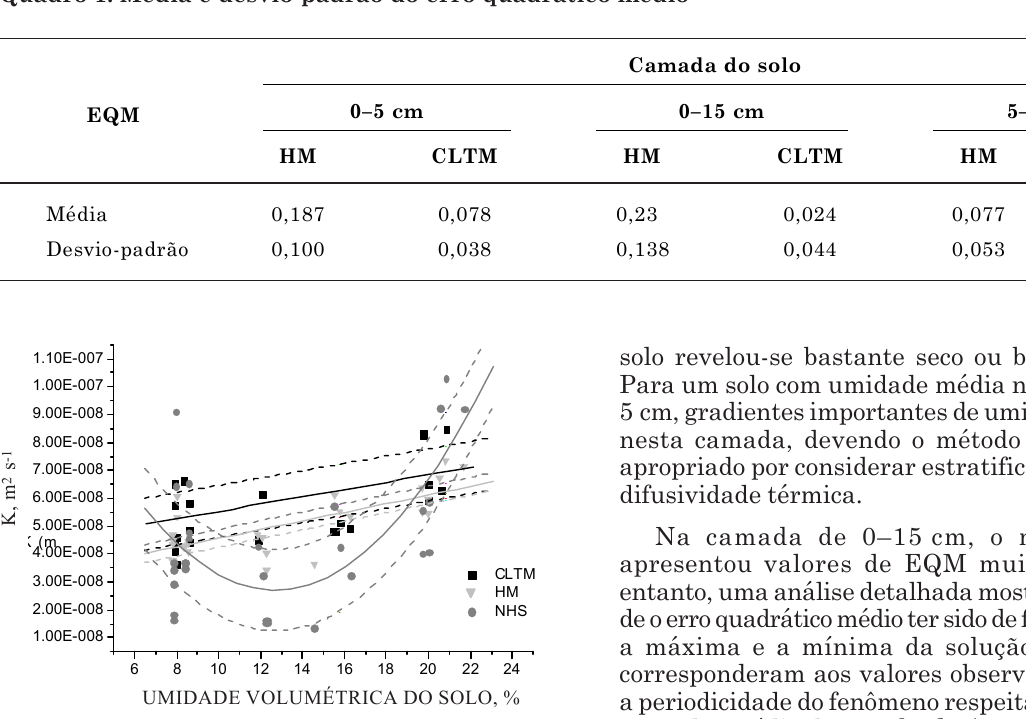
Figura 6. Difusividade térmica na camada de 5–15 cm, segundo os três métodos utilizados (CLTM, HM e